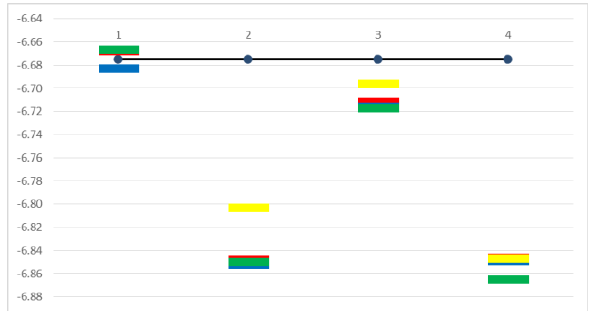
Figure 11. Floor of first level.